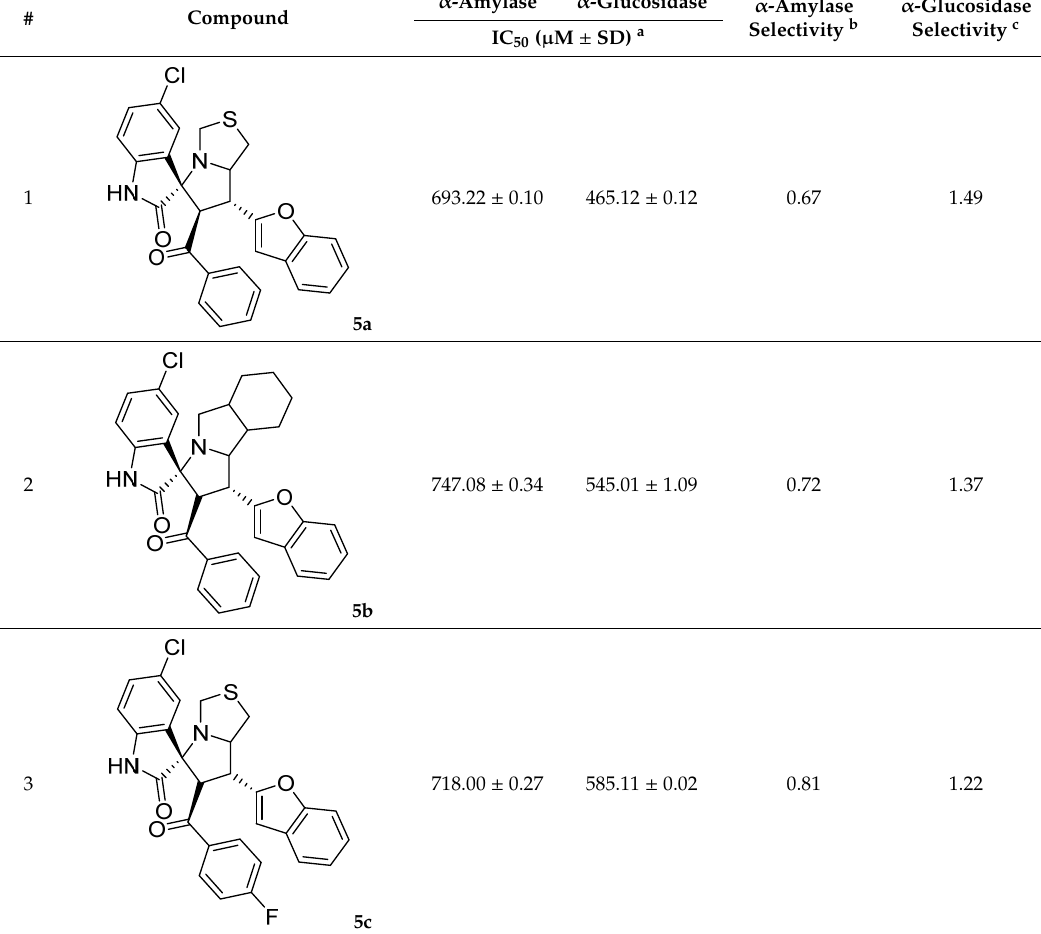
Table 1. Synthesized pirooxindoles and benzo[ b ]furan sca ff olds 5a–r and their biological activity.